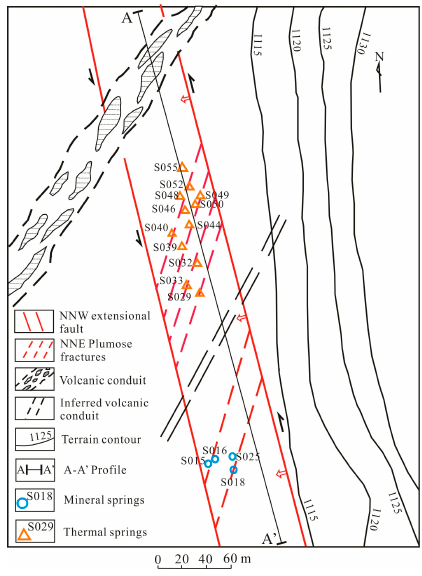
Figure 2. Location of the spring samples and the profile (A ‐ A’) of the study area .